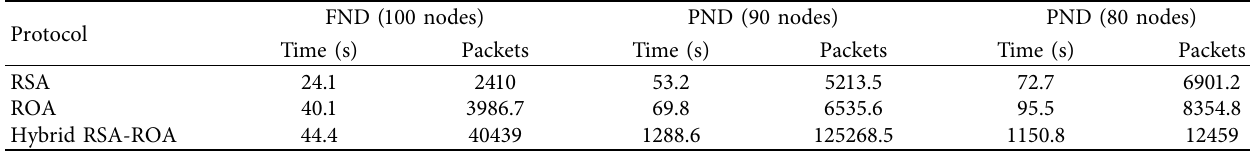
Table 5: Summary of FND and partial node death (PND) for proposed network 1.